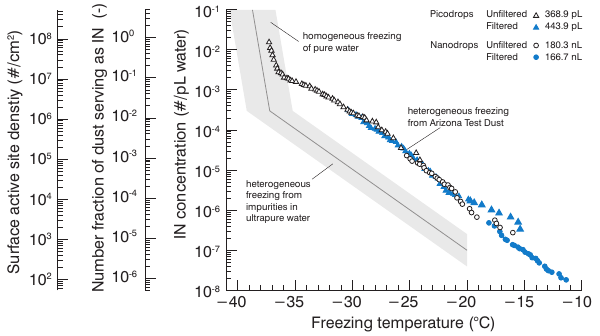
Figure 4. Cumulative ice nuclei spectrum for a suspension of 0.01wt% of ATD in ultrapure water. Open and filled symbols cor- respond to unfiltered and filtered/resuspended experiments, and the numbers in the top right are similar to those in Fig. 3. The fil- tered/resupspended experiments correspond to a pre-concentration of ATD of 50 : 1. The second axis expresses the data as number frac- tion of dust serving as IN based on the dust number-to-mass ratio. The third axis expresses the data as IN-active site (INAS) density based on the specific surface area and density of dust provided by the